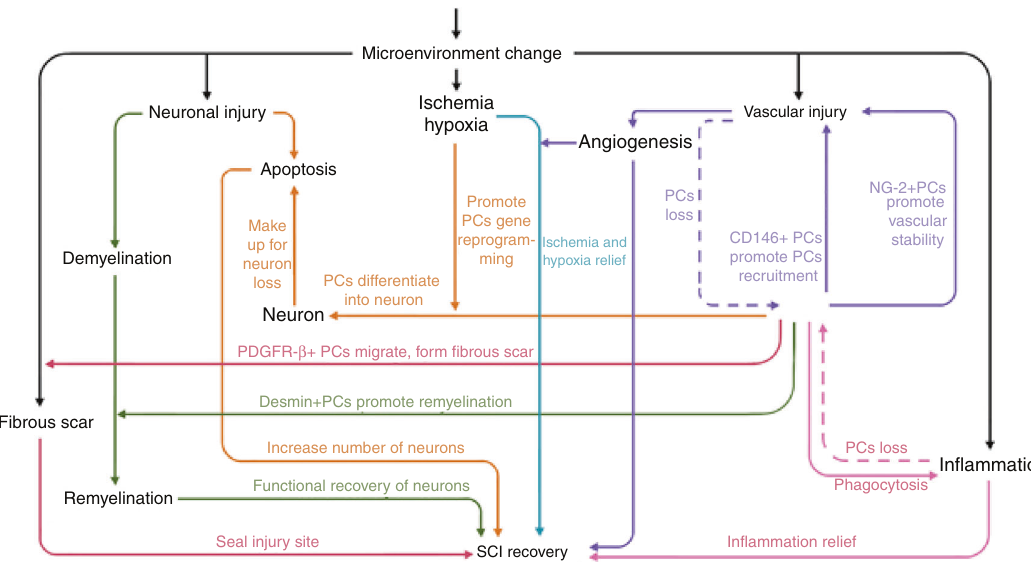
Fig. 3 Relationships between different types of pericytes and the SCI